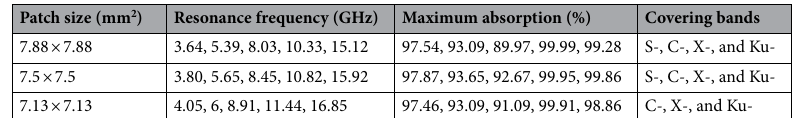
Table 8. Effect of patch size on absorption peaks, resonance frequencies, and covering bands.